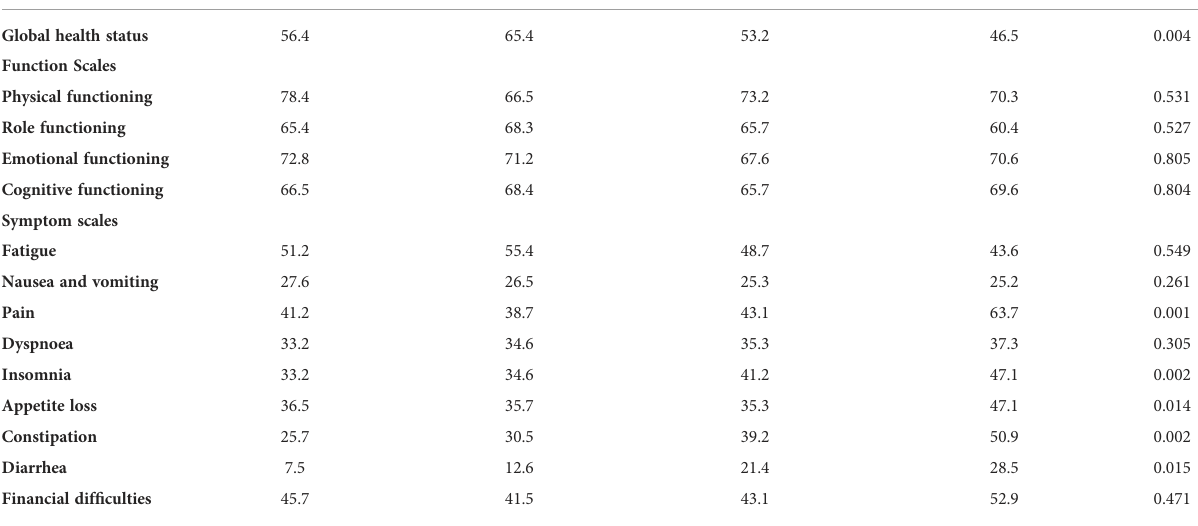
TABLE 3 QOL evaluation (EORTC QLQ-C30 v3.0) in four groups after PSM.